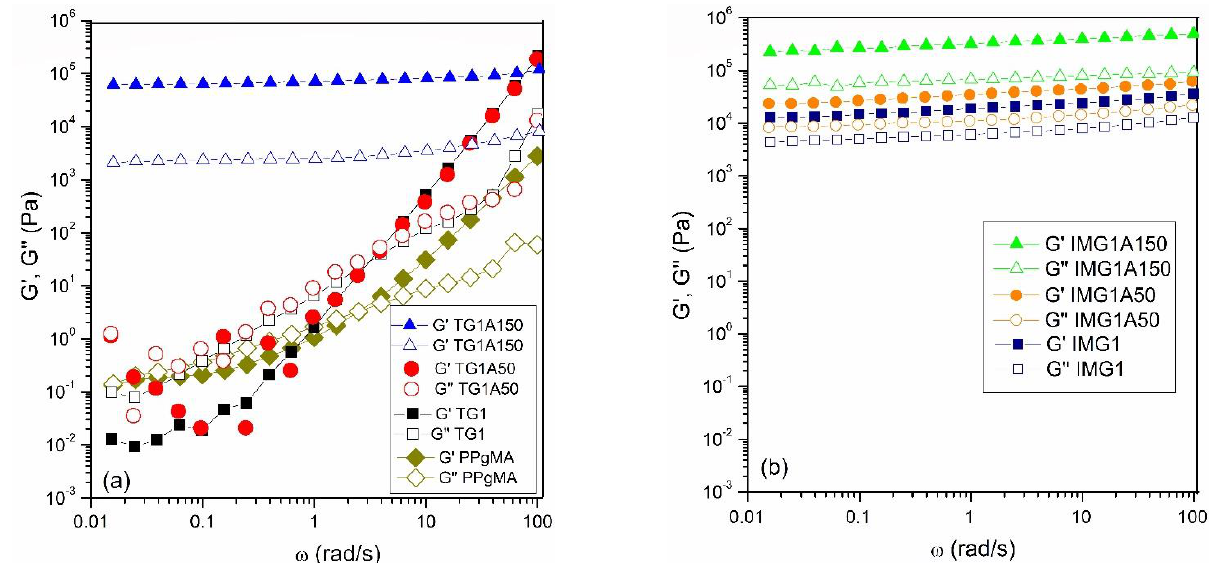
Figure 8. The change in storage ( G′ ) and loss ( G″ ) modulus of ( a ) PPgMA, TG1 and its annealed products and ( b ) IMG1 and its annealed products at various angular frequency (ω, rad/s) and measured at temperature of 160 °C.